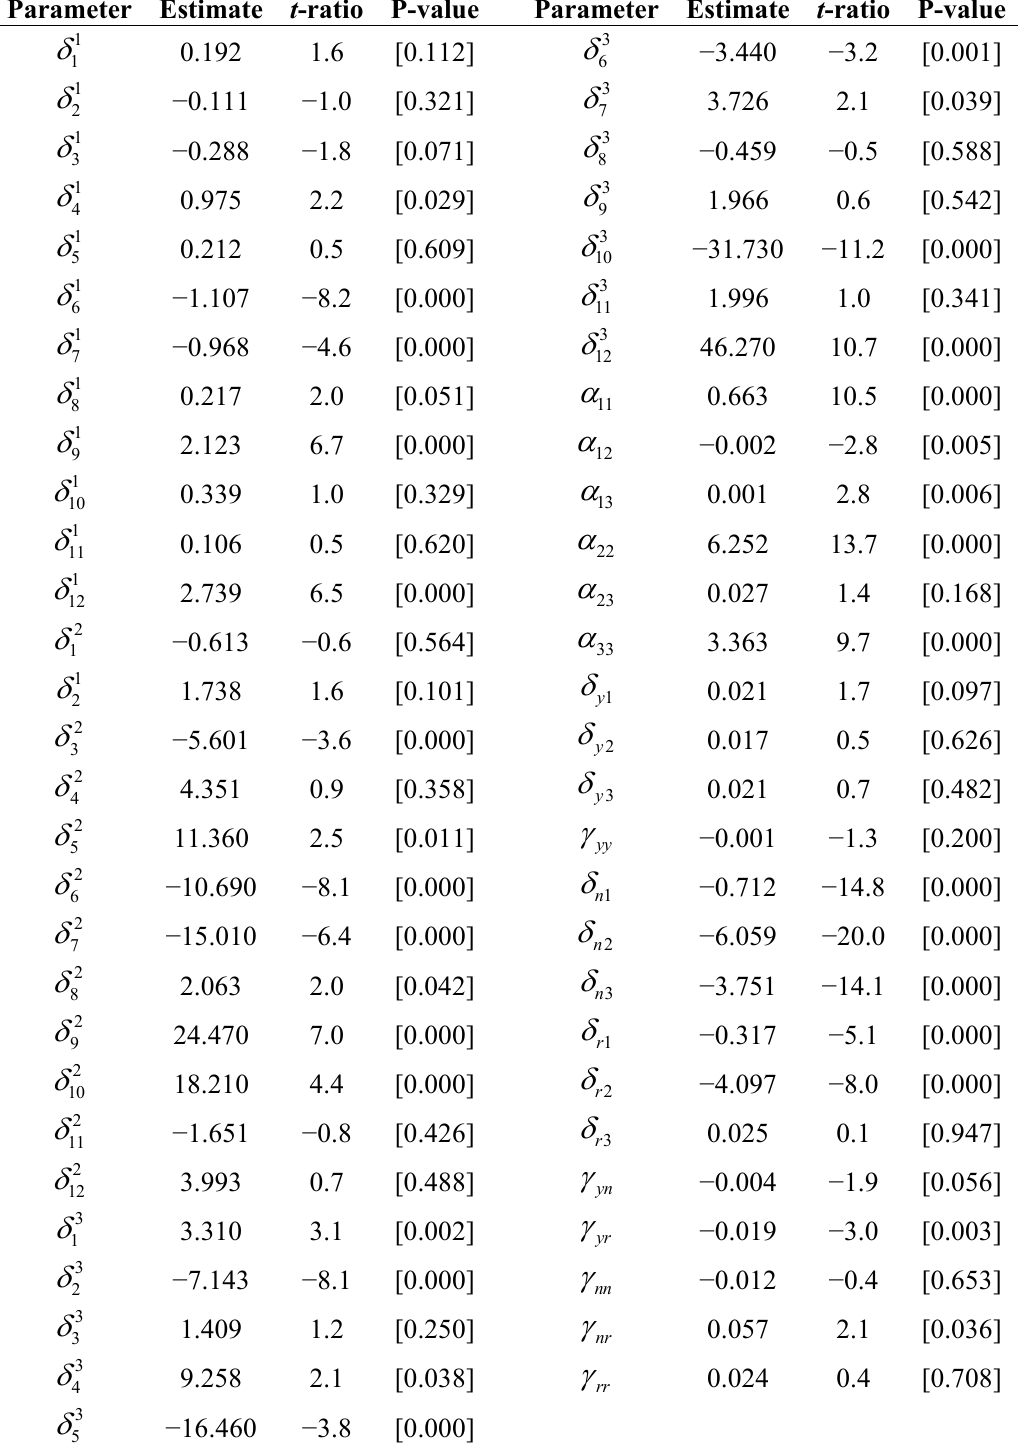
Table 3. Generalized method of moments